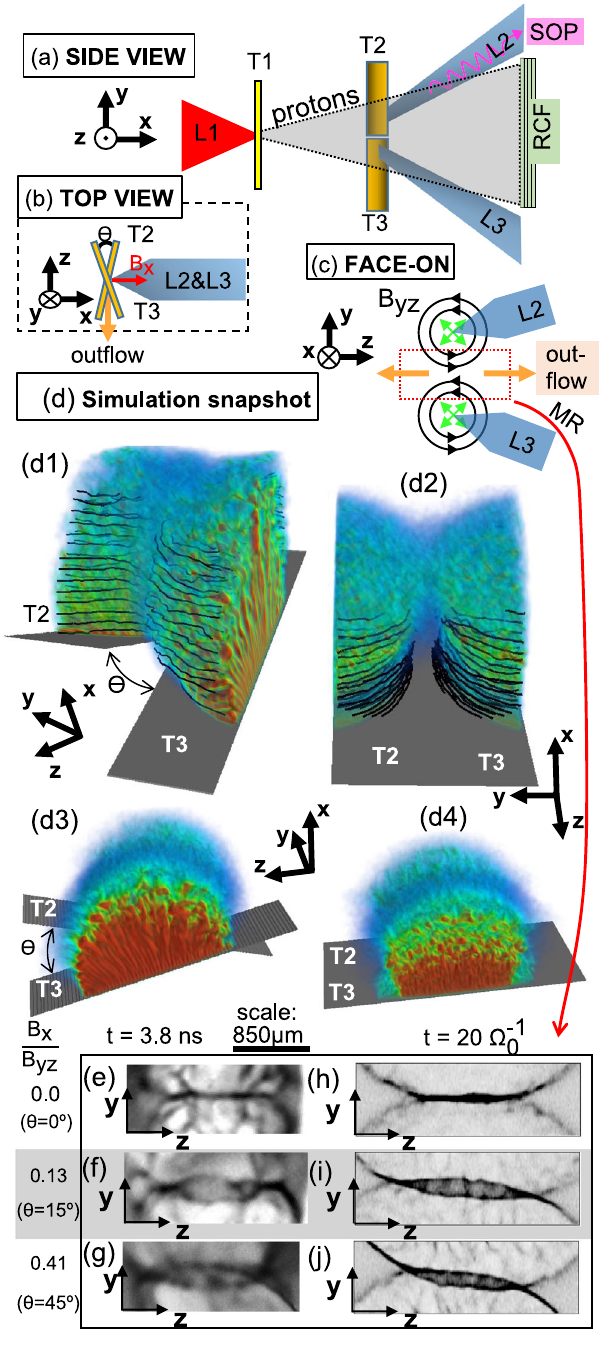
Fig. 1 | Setup of the experiment and simulations, and proton radiography results. Three schematicviews of the experimental setup,along three projections. Thepurplewavyarrowin a indicatesthedirectioninwhichtheopticalself-emission is recorded, while the orange arrow in b indicates the direction of the particle spectrometer in which the ejected particles (ions and electrons) are analysed. The red arrow in b shows the guide- fi eld, which magnitude is varied by changing the angle θ . d Snapshots of a simulation in the tilted con fi guration (d1-d2) and in the coplanar con fi guration (d3-d4) using the 3D hybrid code AKA 53 : the targets are depicted in grey, and electron density in color, and the black lines represent the magnetic fi eld lines. e – j Zooms in the MR region (illustrated by the red dashed rectangle in c ) of the experimental proton de fl ectometry images (with respect to time t , t =0 refers to the start of the laser irradiation), for various strengths of the guide fi eld( B x / B yz gives theratioof the guide fi eld vs.the in-planemagnetic fi elds). e – g Experimental images (snapshots integrated over ~3ps), toward the end of the laser irradiation (which lasts for 5ns). Note that the spatial scale at the top applies only to panels e – g and is relative to the target plane. h – j Corresponding synthetic images of proton-de fl ectometry obtained in the simulations, at a time comparable to that of the experiment, i.e., once we are in the fast linear growth phase of the reconnectionevent. Inboth the experimentaland synthetic de fl ectometry images, the dark regions correspond to an accumulation of